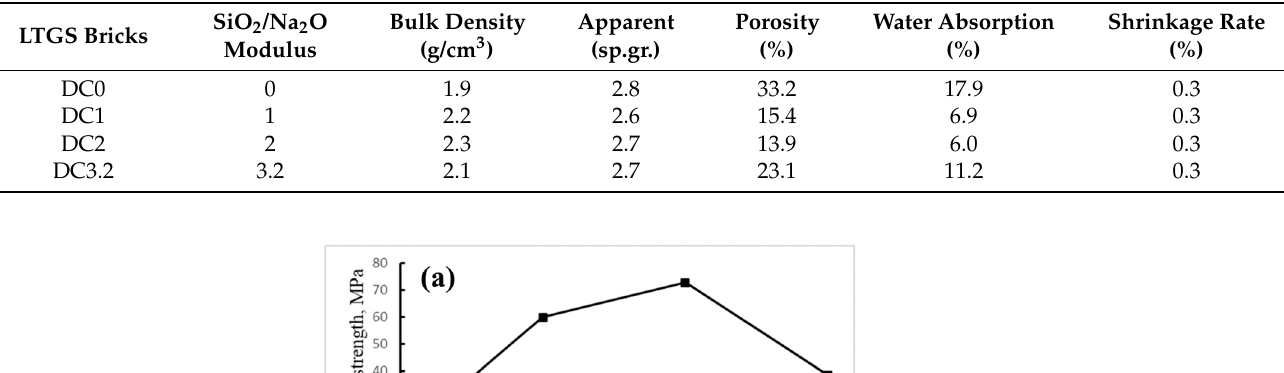
Table 3. Influence of SiO 2 /Na 2 O modulus on the physical properties of LTGS bricks.